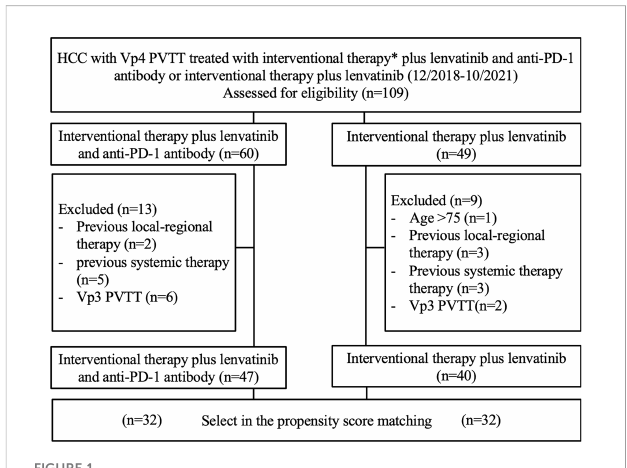
FIGURE 1 Patient selection fl ow chart. * Interventional therapy = 125 I seed strand and PVS implantation plus